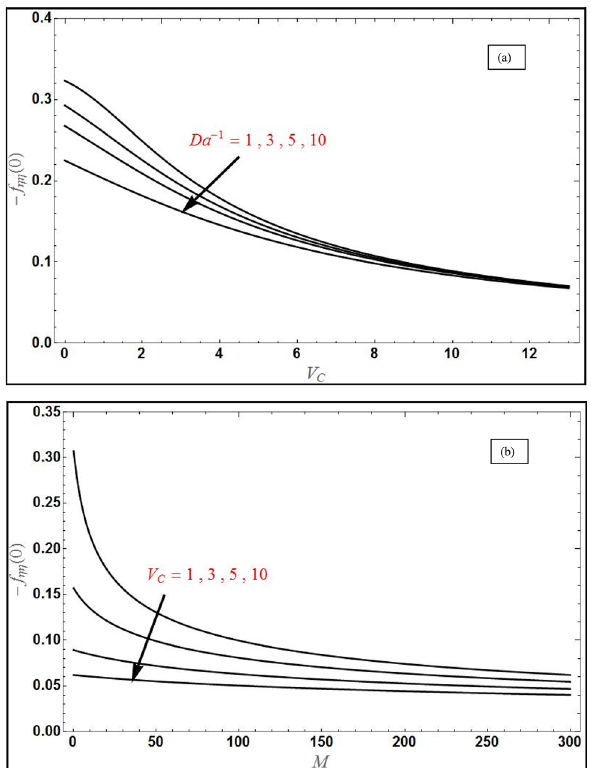
Da − 1 (cid:31) (cid:30)